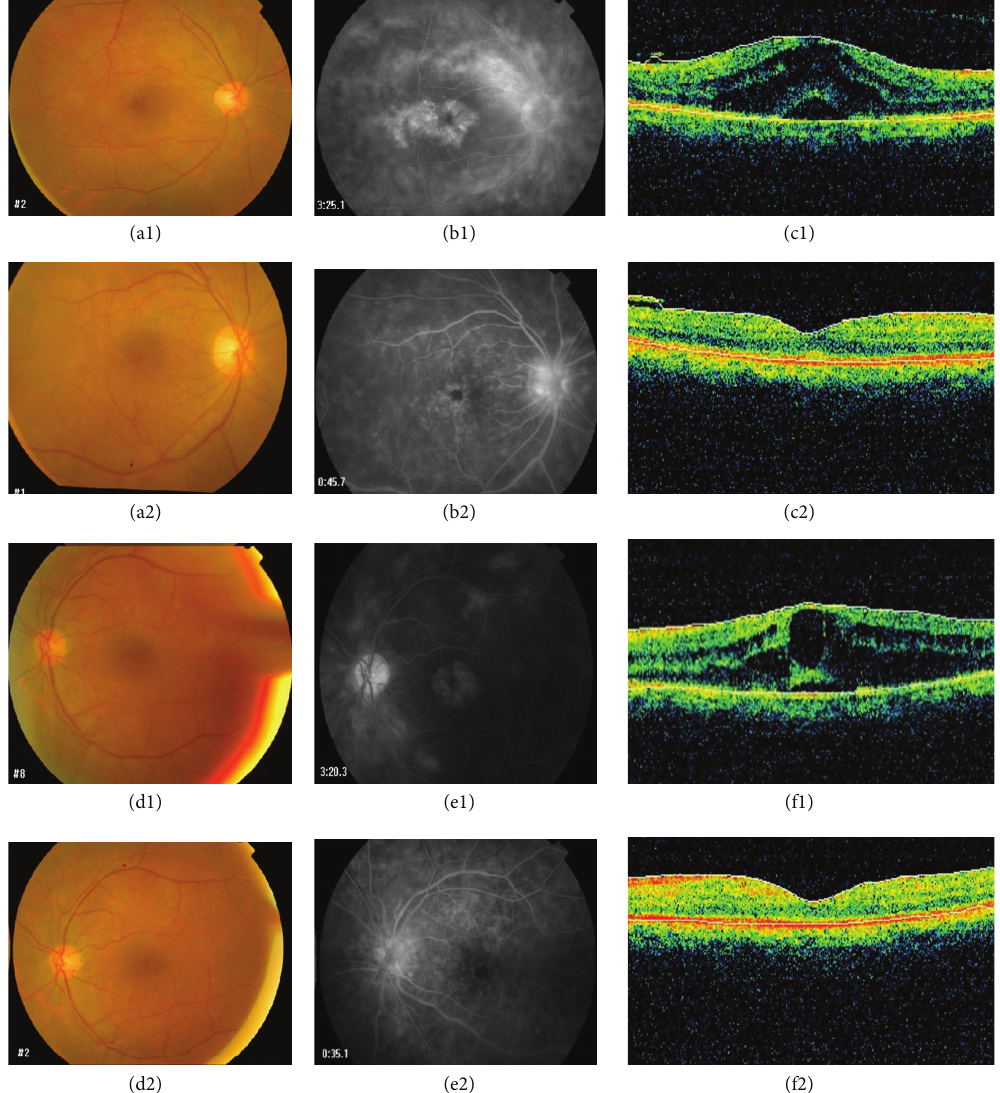
Figure 1: A 56-year-old female with bilateral idiopathic intermediate uveitis and chronic cystoid macular edema. (a1), (b1), and (c1) and (d1), (e1), and (f1) are the fundus photos, fluorescein angiograms, and optical coherence tomography prior to treatment with intravitreal bevacizumab in both eyes. (a2), (b2), and (c2) and (d2), (e2), and (f2) are the fundus photos, fluorescein angiograms and optical coherence tomography, after treatment with intravitreal bevacizumab, which show the response of CME after intravitreal